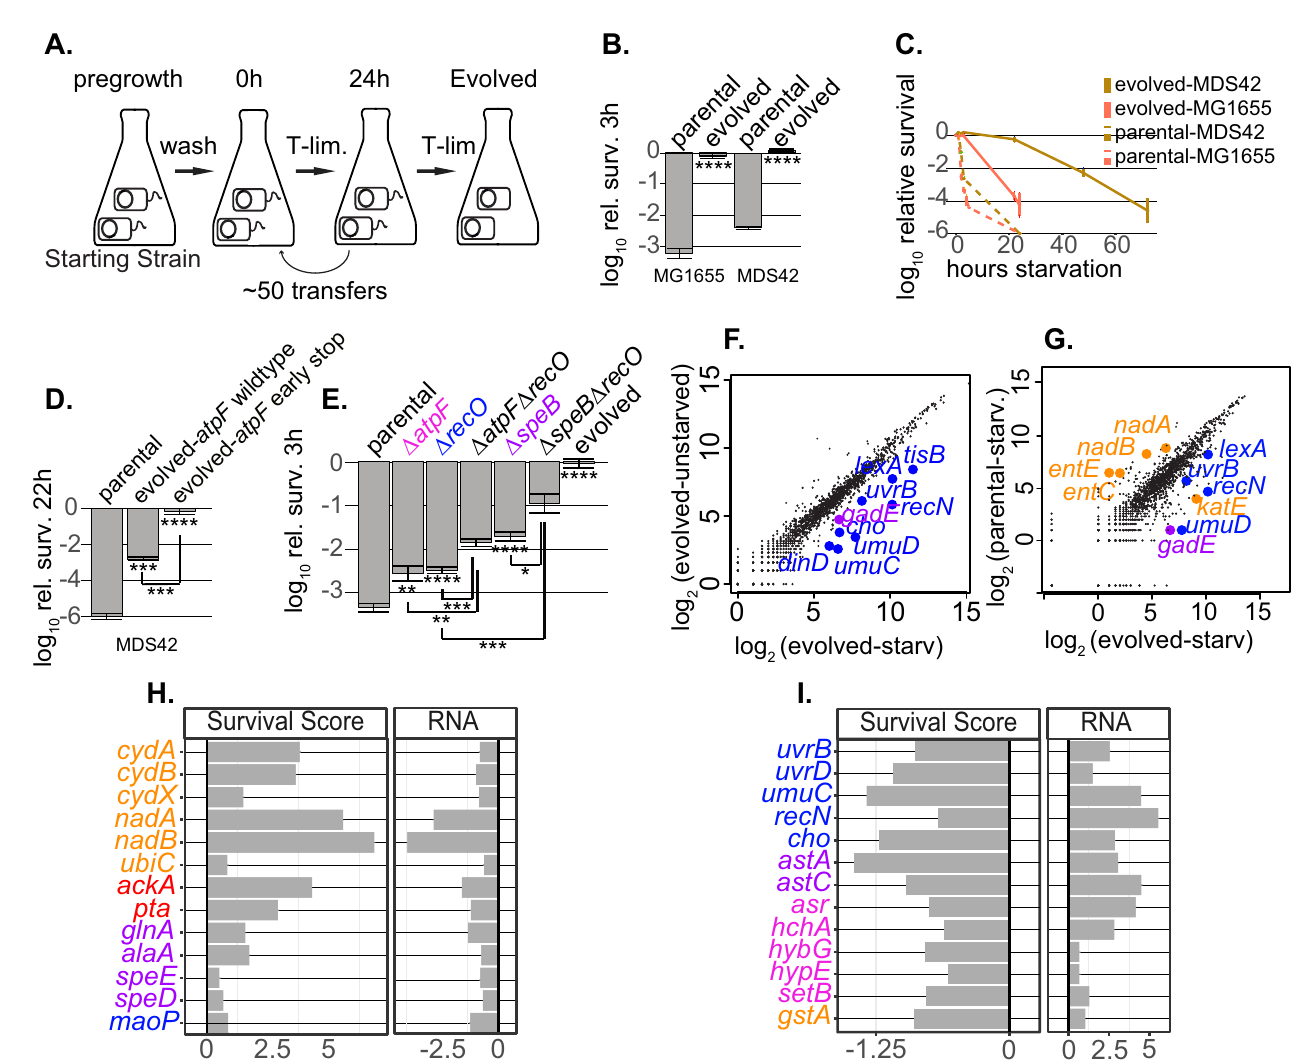
Fig 2. Genetic and transcriptional evidence for the role of pH homeostasis in laboratory evolution of extreme TLD-resistance. (A) Experimental setup of laboratory evolution. Clones of thyA - strains in the MG1655 and MDS42 backgrounds were selected independently in 0.2 μ g/mL thymidine. After roughly 50 transfers, isolates were characterized for enhanced survival. (B) Short-term death assay for evolved isolates and parents at 3h thymidine starvation. The stars in Fig 2 correspond to the p -values as specified in Fig 1 and are calculated using a Welch t-test. (C) Long-term death assay for evolved isolates and parents. The points are averages from independent experiments, with error bars representing standard error of the mean. (D-E) Survival of TLD-sensitive versus various TLD-resistant strains. The stars at the bottom of a bar represent the p -values calculated for that strain compared to the parental strain. The stars under brackets represent the p -values calculated between the strains bracketed. (D) atpF early stop contributes to extreme TLD resistance. Two sibling isolates from the same evolved population share all mutations except an atpF early stop codon (the strain that survives less well has wild type atpF) . The three strains shown are in the MDS42 background. (E) Clean deletion validations at 3h thymidine starvation. All knockouts are in the MG1655 thyA - background. Here and in the rest of this work, purple represents genes in putrescine / glutamate / arginine metabolism, and pink represents genes involved in proton translocation (or sequestration) systems. (F-G) Transcriptome profiling of TLD-sensitive and TLD-resistant strains. RNA was extracted and sequenced 30 minutes into thymidine starvation for the evolved strain in the MDS42 background and its parent strain. RNA was also extracted and sequenced in the unstarved condition. Select genes showing significant differential expression are shown in color. Rockhopper [99,100] uses a negative binomial distribution to estimate the uncertainties in the read counts. The p -values are FDR-corrected using the Benjamini-Hochberg procedure [101]. Genes in the Replication/Repair, ROS, and pH homeostasis pathways are shown in color. For comprehensive tables of the LFC of mRNA expression for the parental and evolved strains, see S7 and S8 Tables. (F) Gene expression of the evolved strain during starvation versus unstarved. (G) Gene expression of evolved versus parental strain during thymidine starvation. (H-I), Select genes with concordant effects across MG1655 and MDS42 backgrounds and across experimental approaches. In each, the left-hand column shows survival scores from the survival profiling experiment in the MG1655 strain and the right-hand column shows LFC of TPM in the evolved versus parental in the MDS42 background during thymidine starvation. (H) Genes that exacerbate TLD. The left-hand-column shows positive survival scores and the right-hand column shows down-regulation of RNA expression levels of the evolved strain vs. parental during starvation. (I) Genes that alleviate TLD. The left-hand-column shows negative survival scores and the right-hand column shows up-regulation of RNA expression levels of the evolved strain versus parental during starvation. See S9 Table for the full list of genes showing concordant effects.